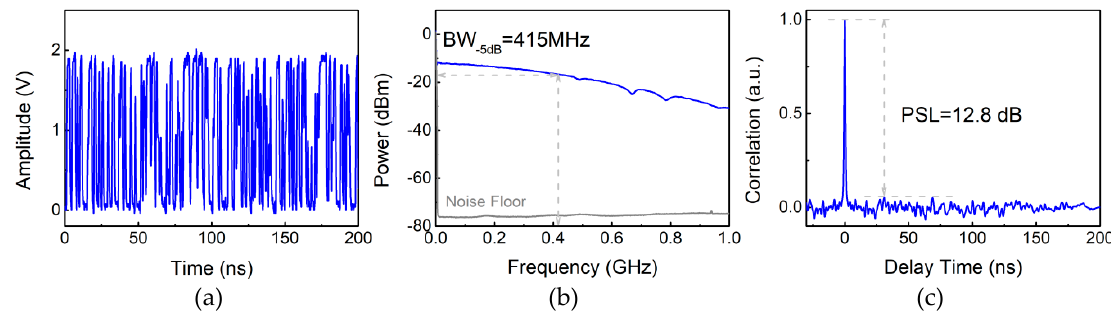
Figure 3. ( a ) Temporal waveform, ( b ) power spectrum, and ( c ) autocorrelation trace of the Boolean-chaos signal.